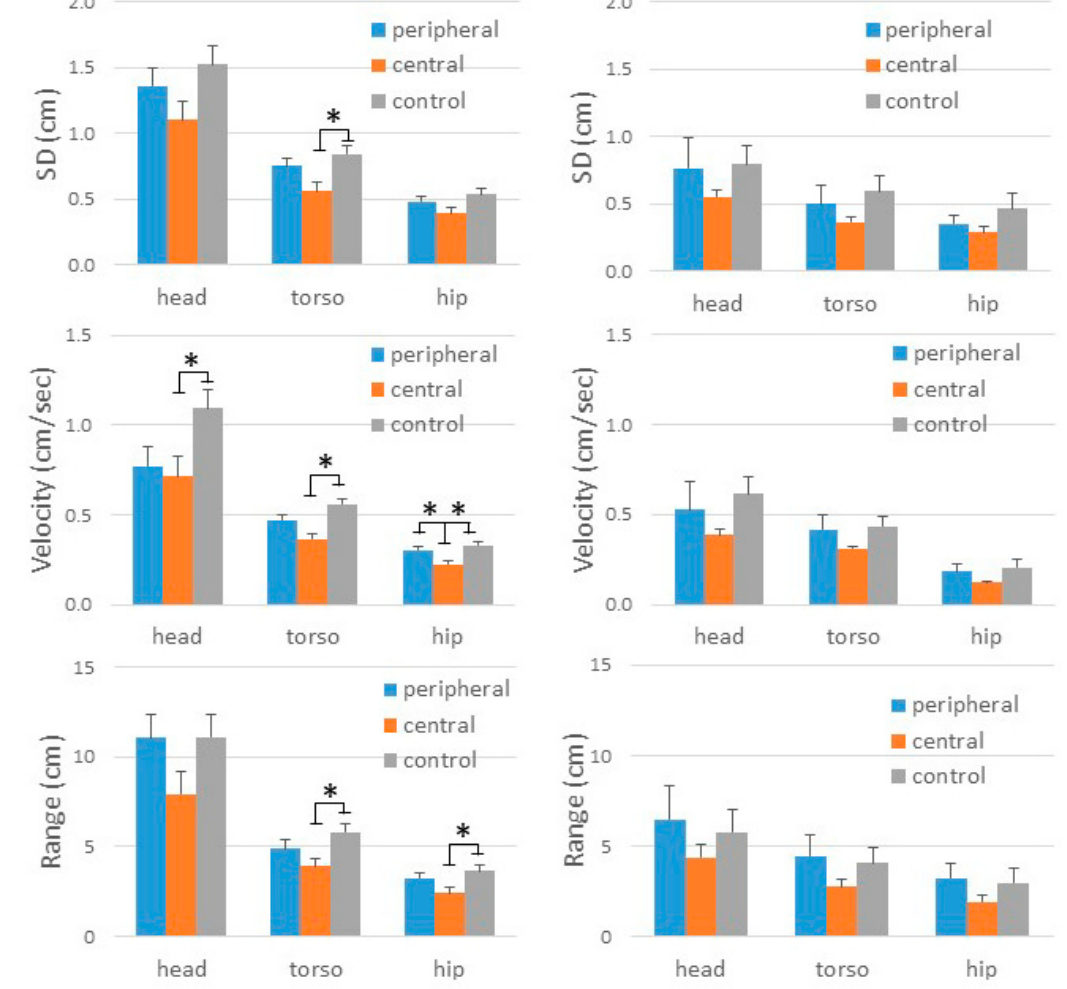
Figure 2. Movement data from the head, torso and hip as standard deviation (SD) (top panel), velocity (middle panel), and range (bottom panel) in the anterior-posterior (AP) (left panel) and medio-lateral (ML) (right panel) axes for three experimental groups. Error bars represent ± 1 SE of the mean. * p < 0.05.